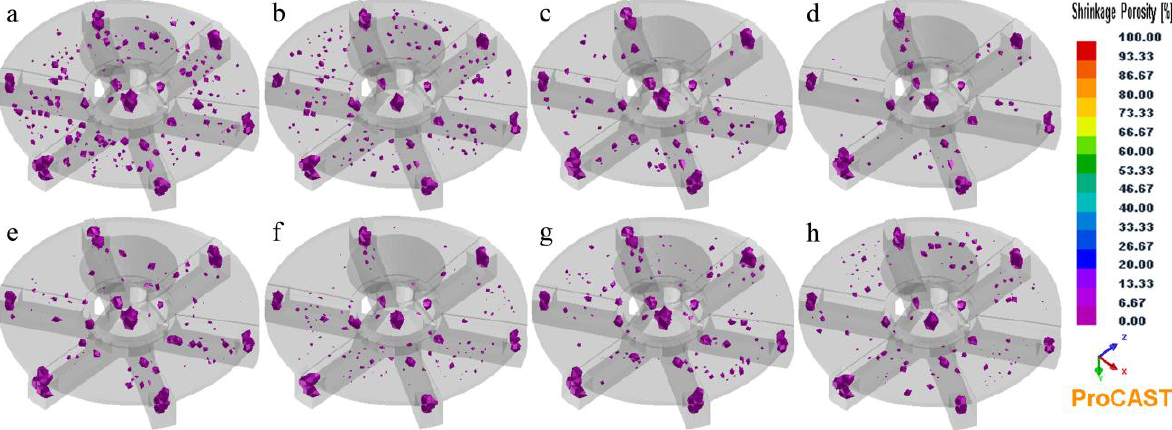
Figure 1. Three-dimensional drawing of runner system for test casting.